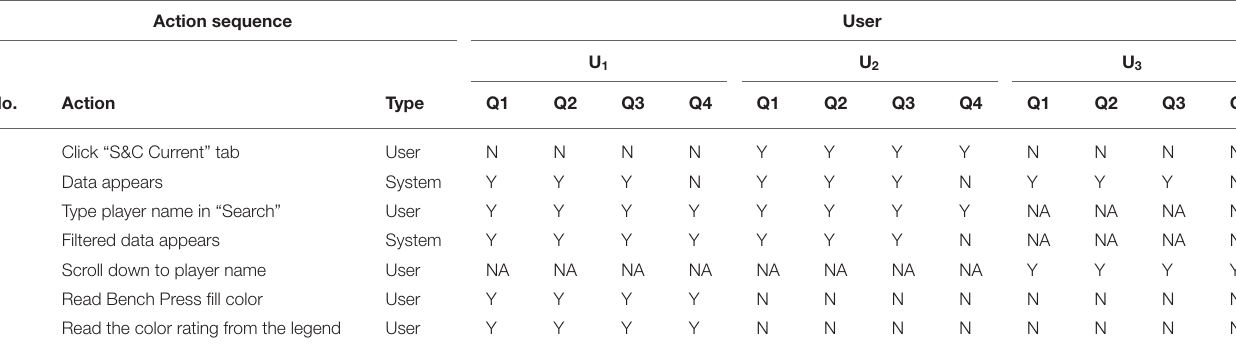
TABLE 5 | Four-question cognitive walkthrough corresponding to the second task (T 2 ) used to evaluate the usability of the data visualization system. Action